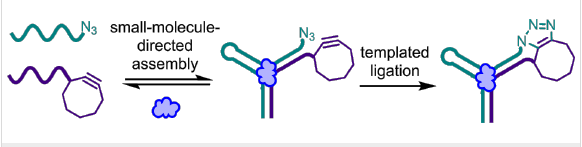
Figure 2: Split aptamers use molecular recognition to drive the assembly of two DNA strands. Placing reactive functional groups at the termini of the split aptamer fragments enables these assembly events to be covalently trapped. Reprinted with permission from [11]. Copy- right (2011) American Chemical